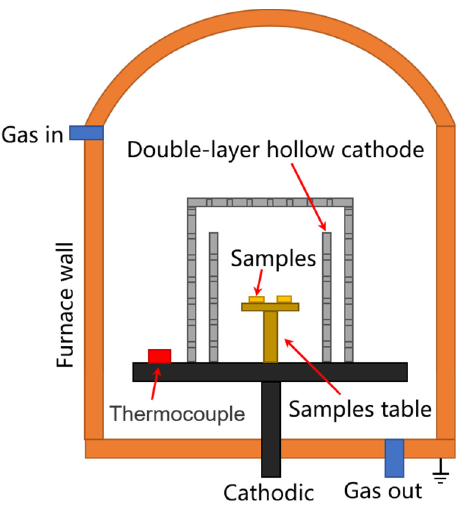
Figure 1. Schematic diagrams of hollow cathodic plasma source nitriding furnace device. Table 2. The preparation process of different samples.